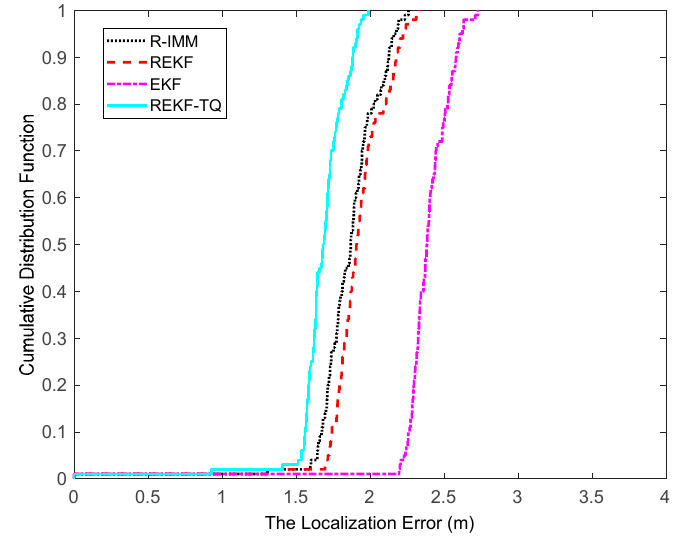
Figure 4. The localization error